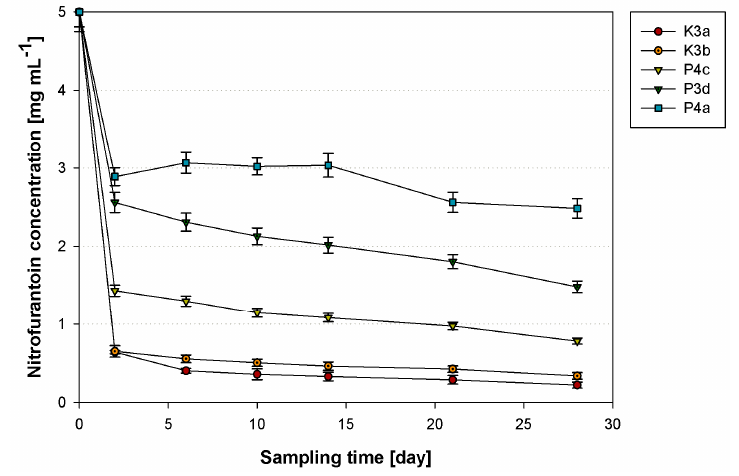
Figure 7. The nitrofurantoin removal in cultures with strains Sphingomonas paucimobilis (K3a), Ochrobactrum antrophi (K3b), Rhizobium radiobacter (P4c), Pseudomonas aeruginosa (P4a), and Sphingobacterium thalpophilum (P3d); results are reported as the mean values calculated from three independent